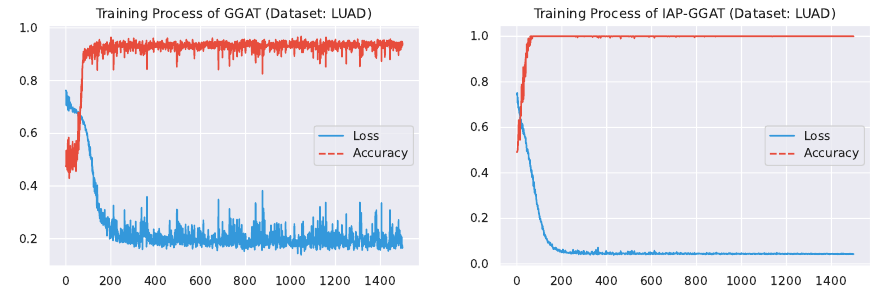
Figure 10. Training process of GGAT and IAP-GGAT on LUAD dataset.